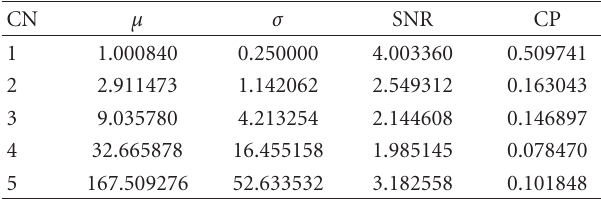
Table 7: Statistical information about the best class number for clinical PET volume of nonsmall cell lung cancer